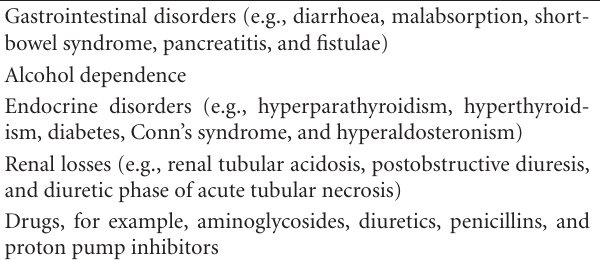
Table 1: Causes of hypomagnesaemia.